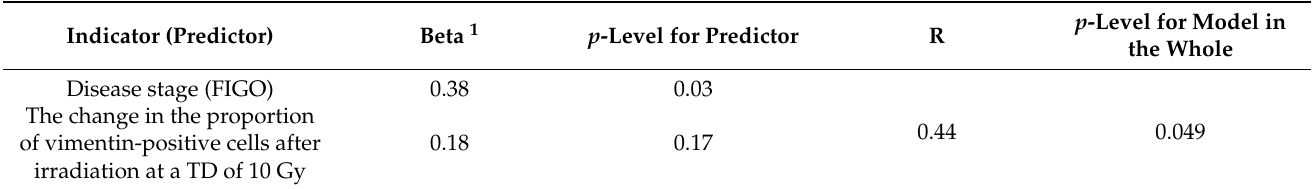
Table 3. The results of multiple regression analysis of the dependence of tumor regression degree on disease stage and postradiation change in vimentin